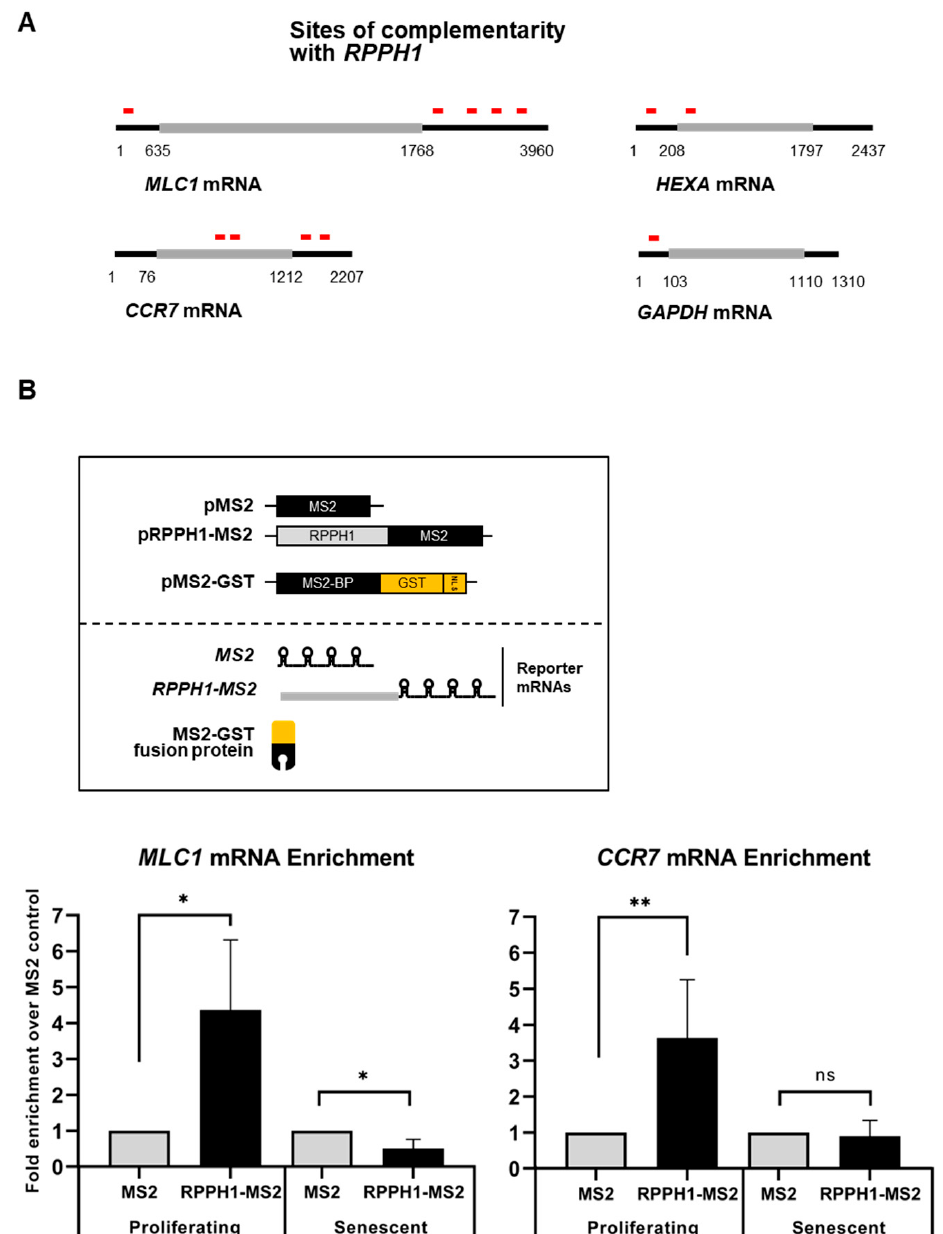
Figure 4. RPPH1 RNA interacts with its target mRNAs using complementary sequences. ( A ) Sites of complementarity with RPPH1 RNA on MLC1 , HEXA , CCR7 , and GAPDH mRNAs. ( B ) MS2-GST pull down analysis to detect MLC1 and CCR7 mRNAs in proliferating and senescent fibroblasts. MLC1 (left) and CCR7 (right) mRNA pull-down enrichment comparing proliferating and senescent cells as measured by RT-qPCR normalized with GAPDH mRNA. Data in ( B ) are average +/ − S.D of independent three experiments. Asterisks denote statistical significance (Student’s t test): ns p > 0.05, * p ≤ 0.05, ** p ≤ 0.01.